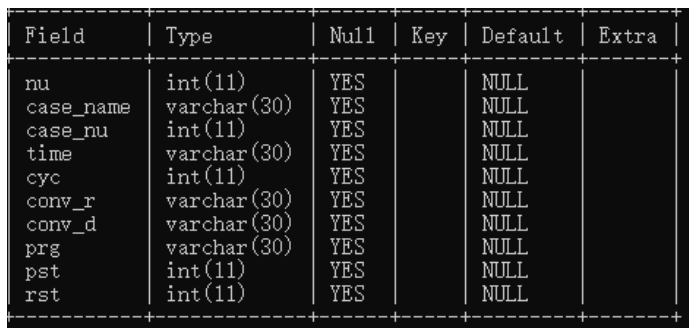
Fig. 4 Table layerstatus.